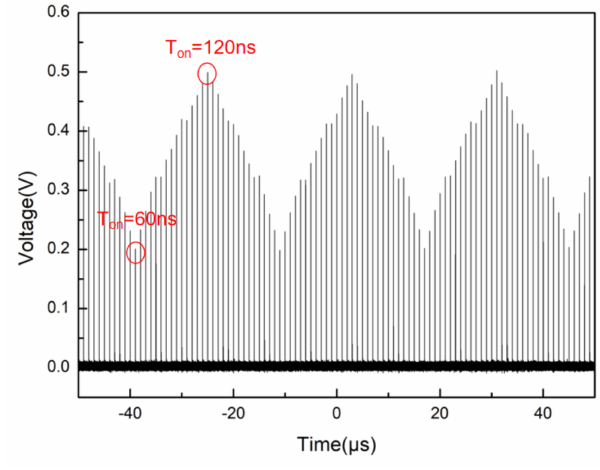
Figure 16. An example of power